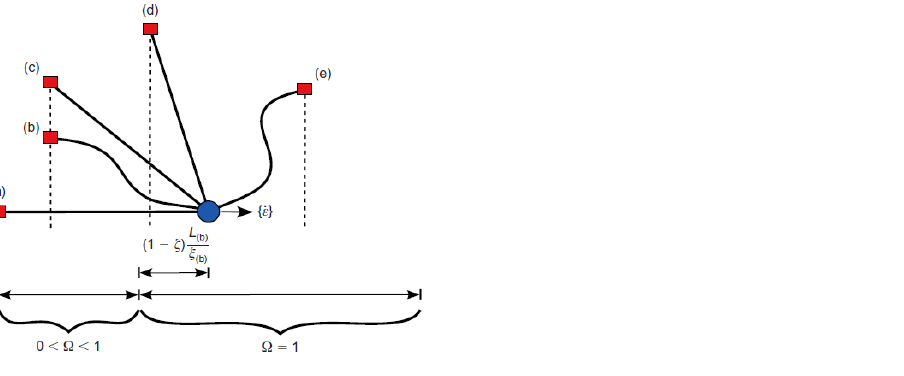
Figure 5. Ω value cases for different brick locations (red squares marked with the letters (a) to (e)) according to the strain increment direction. The strain point is marked with the blue dot (after [44]).